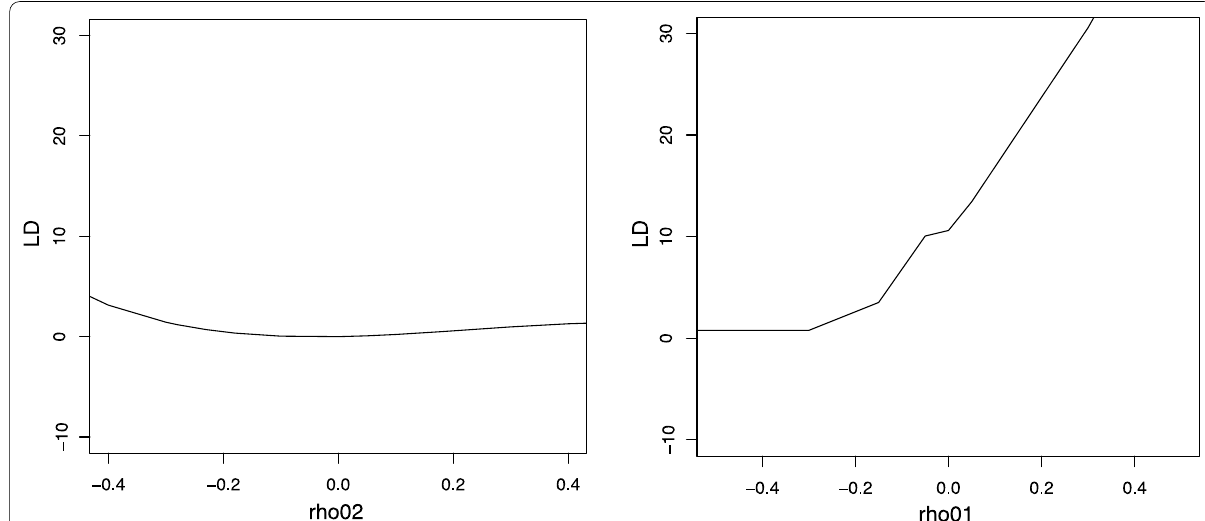
The sample size is 1236 establishments with 865 respondents, 55 noncontacts and 316 refusals